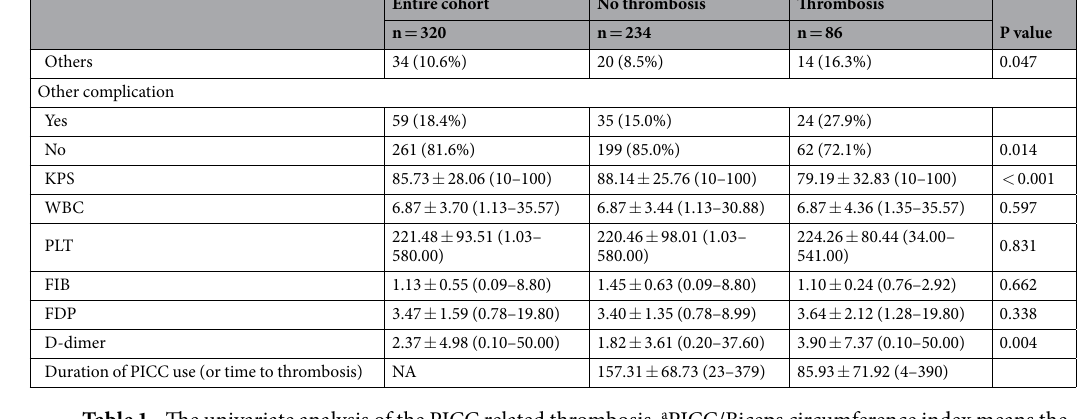
Table 1. The univariate analysis of the PICC related thrombosis. a PICC/Biceps circumference index means the diameter of PICC tube/the biceps circumference * 100. b The order of thoracic